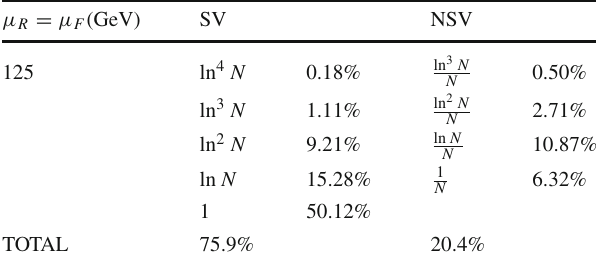
Table 4 % contribution of SV distributions and NSV logarithms to the Born cross section at NNLO at μ R = μ F = 125 GeV in N